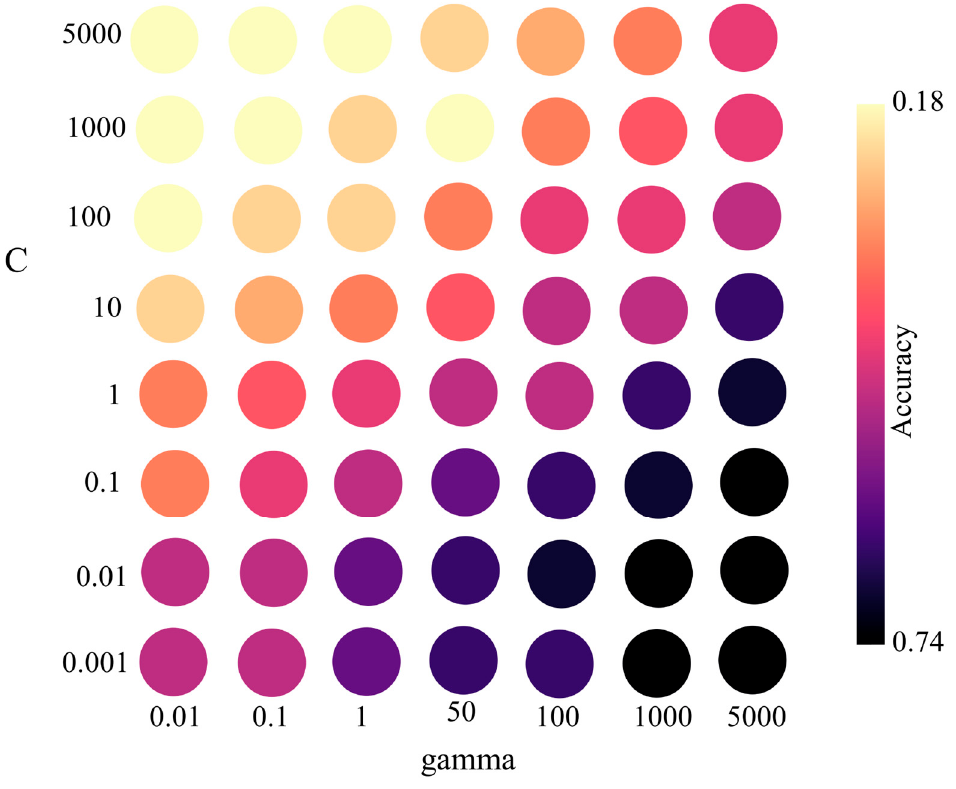
Figure 3. Relation between accuracy and parameters (C and γ ) of the SVM classifier obtained from data subsets of training samples.